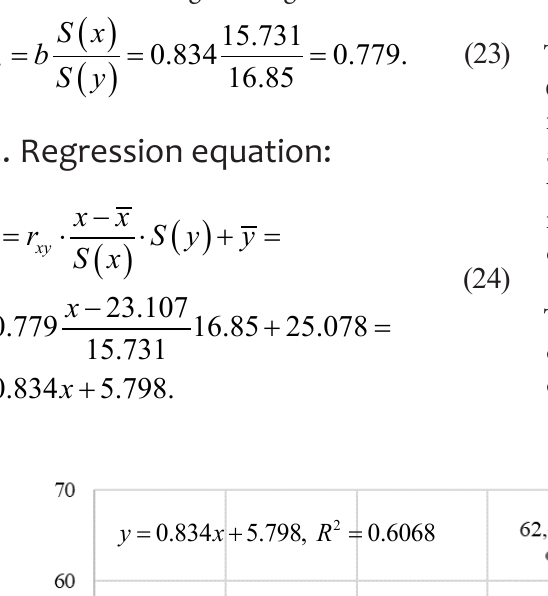
The regression coefficient b = 0.834 shows the av- erage change in the effective indicator (in units of measure y) with an increase or decrease in the val- ue of factor x per unit of measurement. With an increase of 1 unit of trust, GDP per capita rises by an average of 0.834.